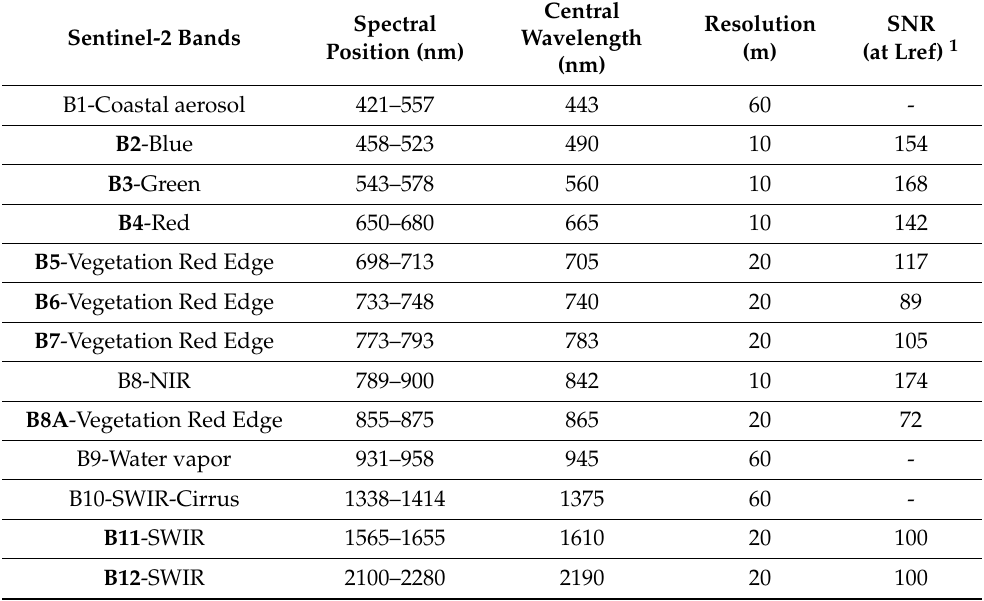
Table 2. Characteristics of the multispectral instrument aboard the Sentinel-2A satellite. Bands shown in bold font represent those selected for retrieving soil organic carbon